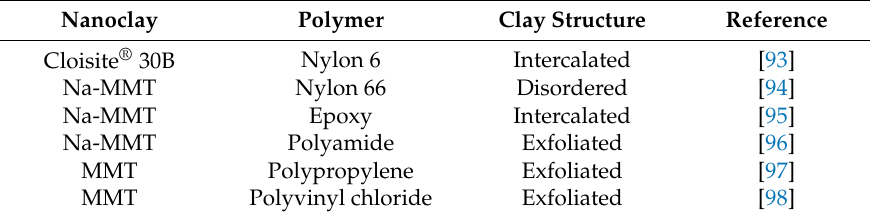
Figure 3. Melt-blending method scheme. Figure 3. Melt ‐ blending method scheme. Polymer/nanoclay prepared by the melt-blending method and dispersion states. Table 3. Polymer/nanoclay prepared by the melt ‐ blending method and dispersion states. MMT: MMT: montmorillonite.